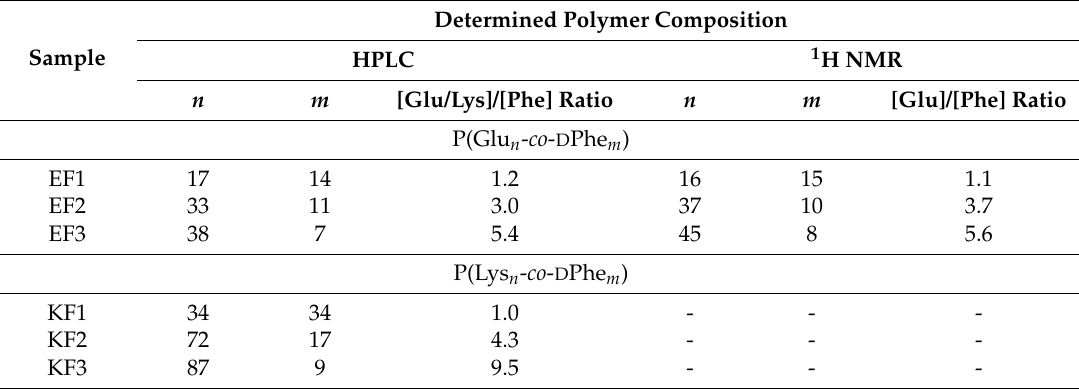
Table 2. Composition of amphiphilic random polypeptides and polymer yields after deprotection.